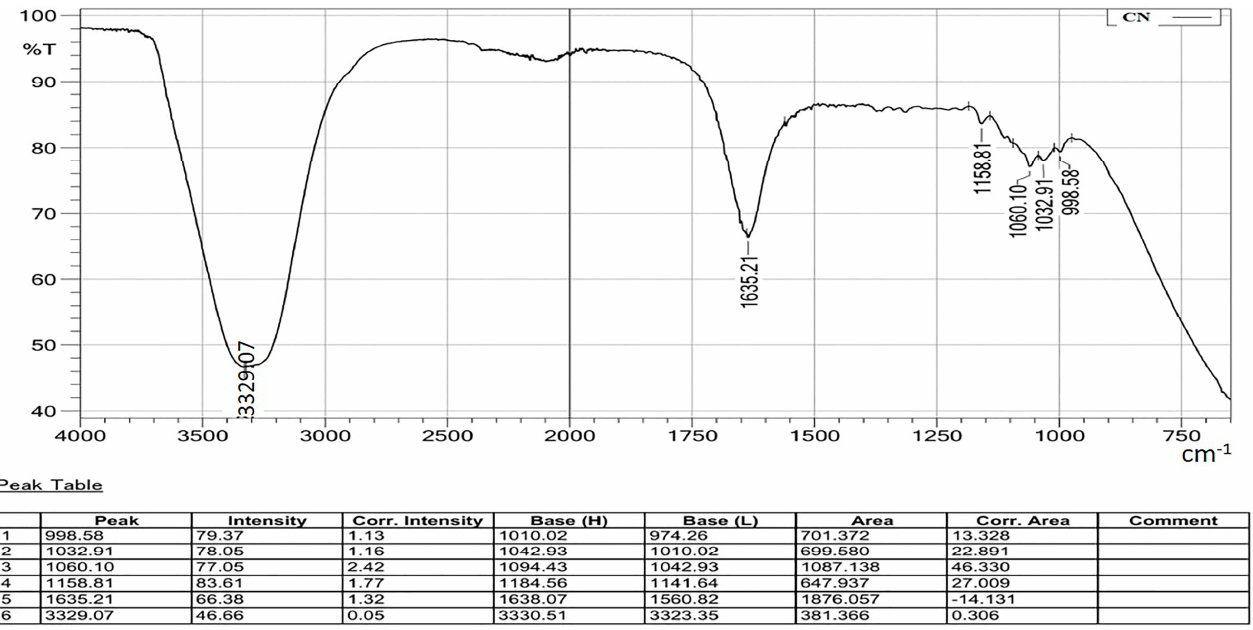
Figure 3. Nanocrystals’ length size and zeta potential correlation.